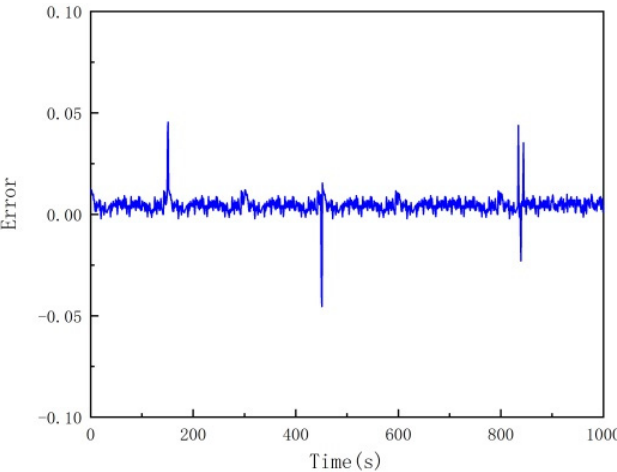
Figure 8. Error between estimated voltage and test voltage.